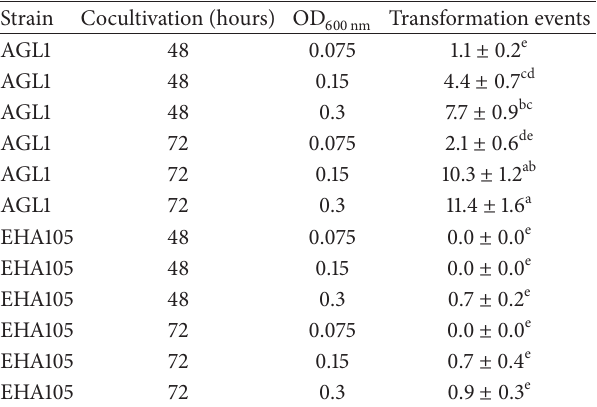
Table 1: Number of transformation events per gram of fresh mass in line L01 after 120 days on selective medium. LBA4404 strain did not show transformation events.